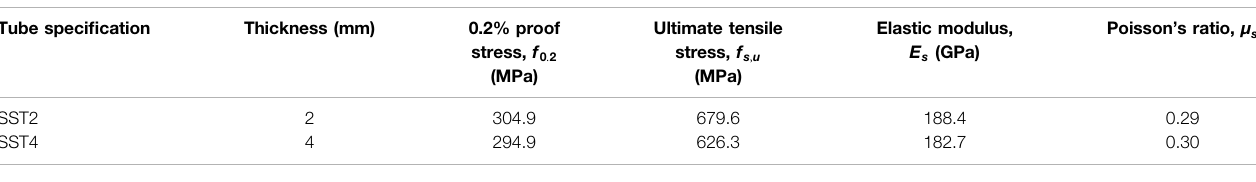
TABLE 2 | Material properties of stainless steel tubes.